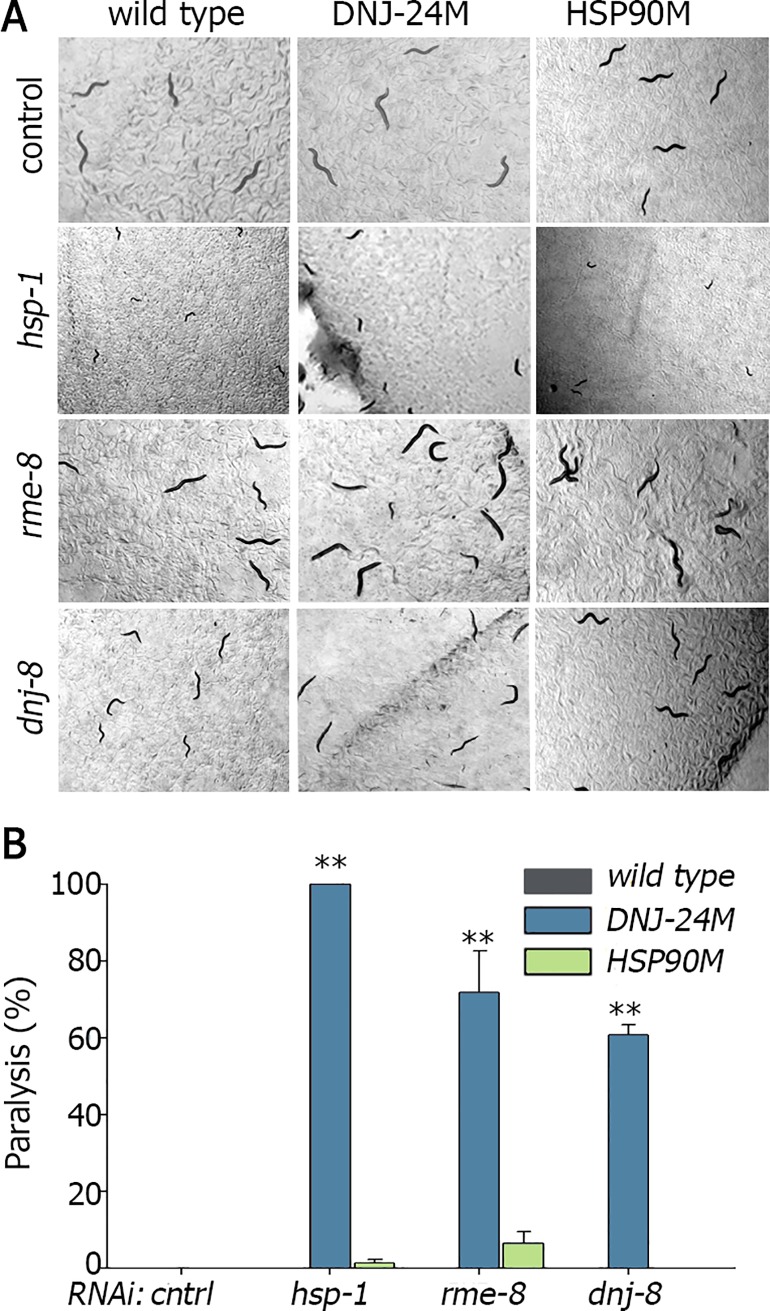
Muscle over-expression of dnj-24 disrupts chaperone interactions, exposing sensitivity to specific chaperone down-regulation.(A) Age-synchronized L1 wild type, DNJ-24M or HSP90M animals grown at 15°C were transferred to plates containing control, hsp-1, rme-8, or dnj-8 RNAi-expressing bacteria, and images were taken on day 1 of adulthood. (B) Age-synchronized wild type, DNJ-24M or HSP90M animals treated as in (A) were scored for motility on day 1 of adulthood. Data are presented as means ± SEM of 3 independent experiments.